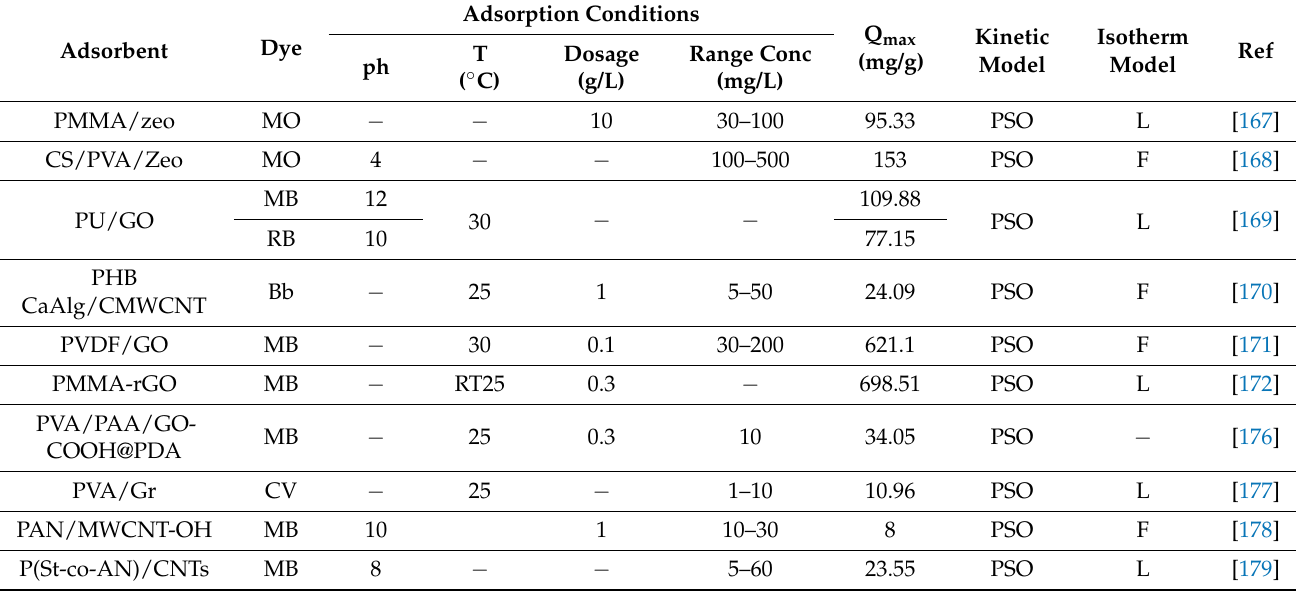
Table 6. EPNFs/clay nanocomposites and EPNFs/carbon nanomaterials as adsorbents for removal of dyes.